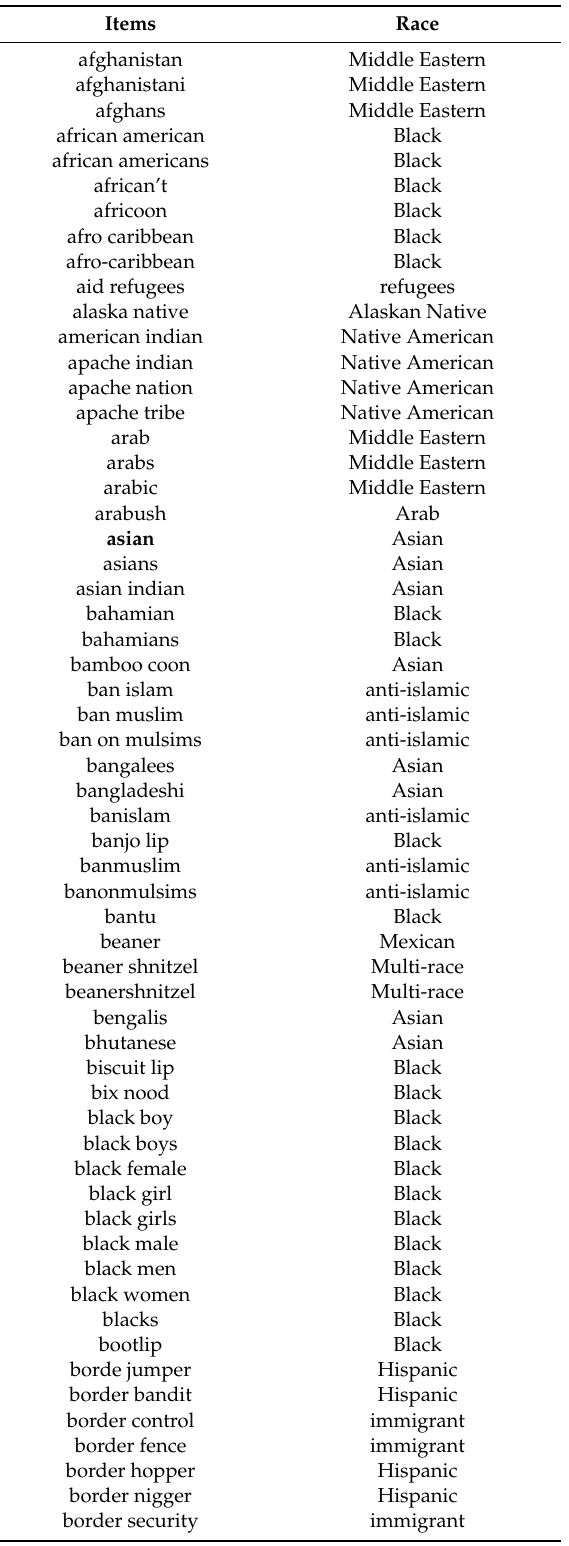
Table A1. Race terms used in Twitter data Collection with most commonly occurring terms bolded.